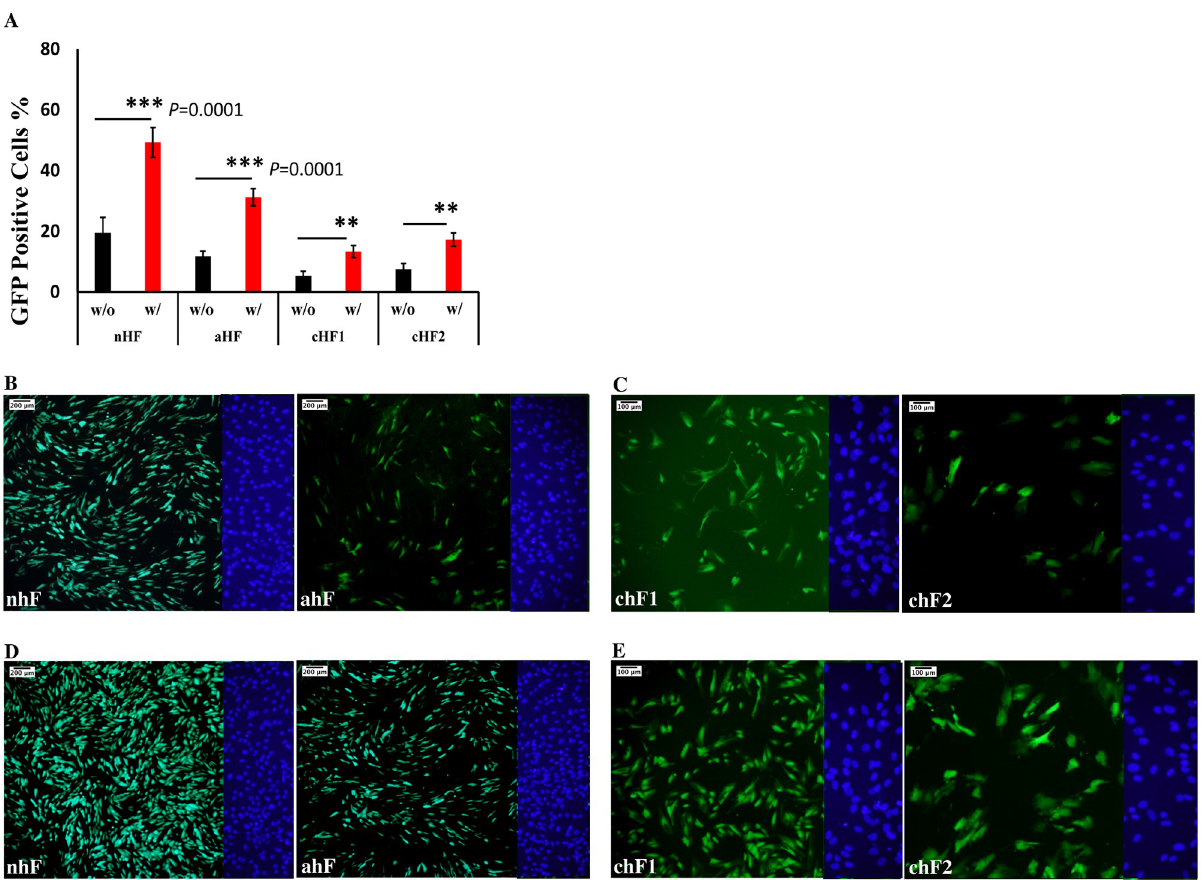
Fig 1. Optimization of the reprogramming procedure. (A) Comparison of the GFP positive fibroblasts in different groups with (w/) and without (w/ o) applying centrifugation. A paired-sample t-test was conducted to compare the percentage of transduced GFP positive cells that either underwent centrifugation or not ( ��� p < 0.0001; �� p < 0.05)(n = 3). (B) GFP expression in nhF and ahF fibroblasts 48 hours after transduction. (C) GFP expression in chF1 and chF2 48 hours after transduction. (D) GFP expression in nhF and ahF 48h after transduction and centrifugation. (E) GFP positive cells in chF1 and chF2 48h after transduction and centrifugation. DAPI staining pictures of the right side of each field were shown.